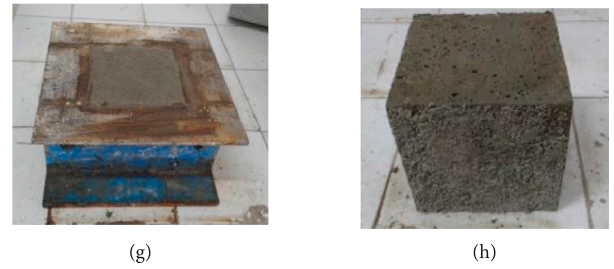
Figure 3: Steps of mixing and preparing specimens.